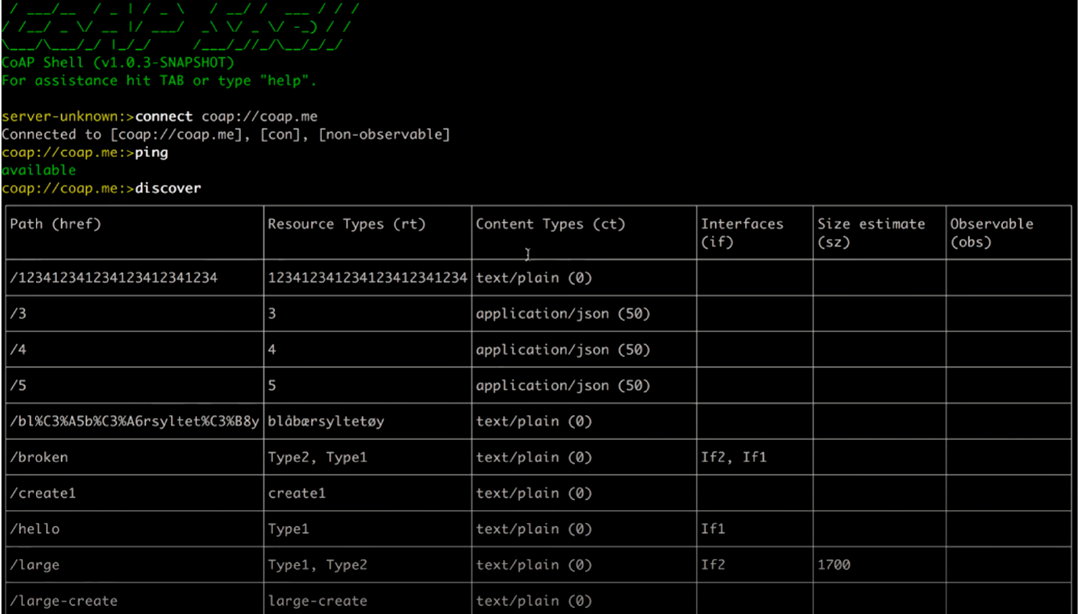
Figure 21. CoAP protocol testing in the CoAP Shell library.